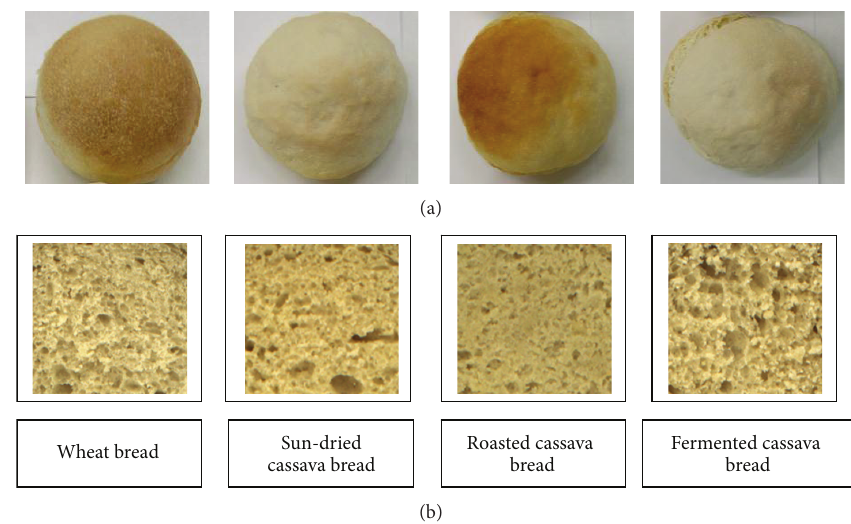
Figure 4: Composite bread made with 40% cassava flour and 3% of HM-pectin. Crust colour (a) and crumb structure (b).